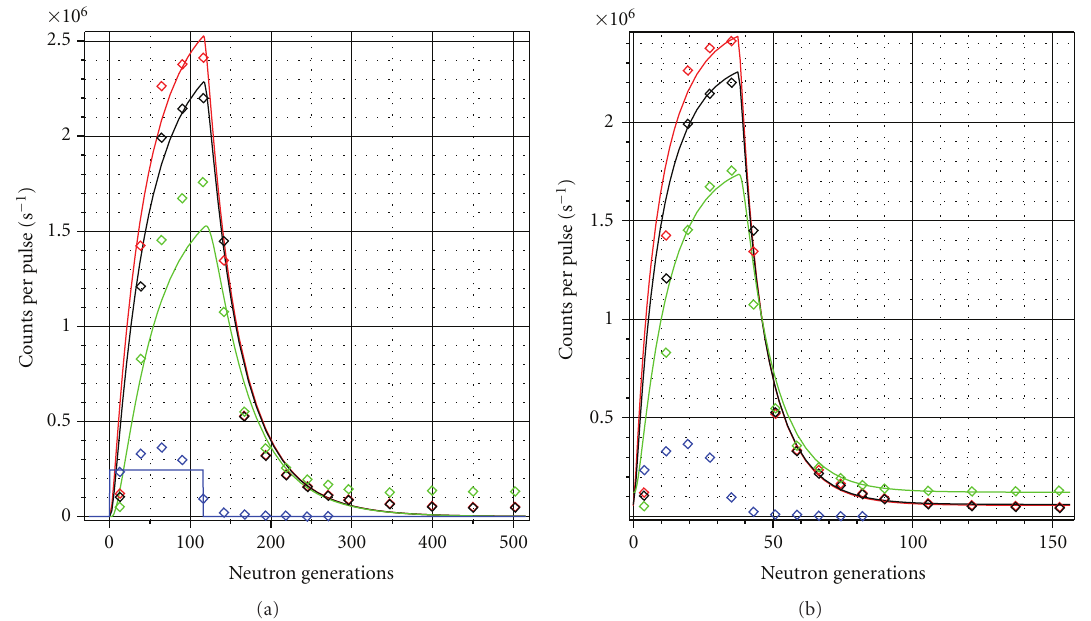
Figure 10: Comparison of the analytical results gained with the analytical solution of the time dependent di ff usion equation (one-group— (a), two-group—(b)) with the experimental results for the SC3A configuration of the YALINA-Booster